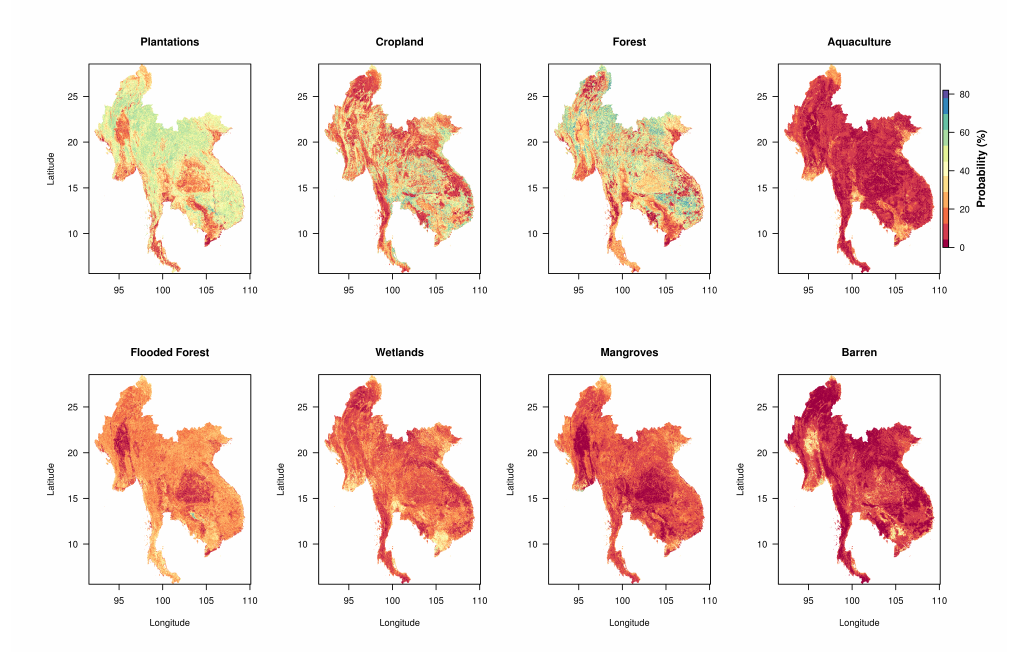
Figure 6. Probability change maps for ‘Specific to Generic’ category for the different land cover types. The maps show the probability of a pixel to change into any other category for the year